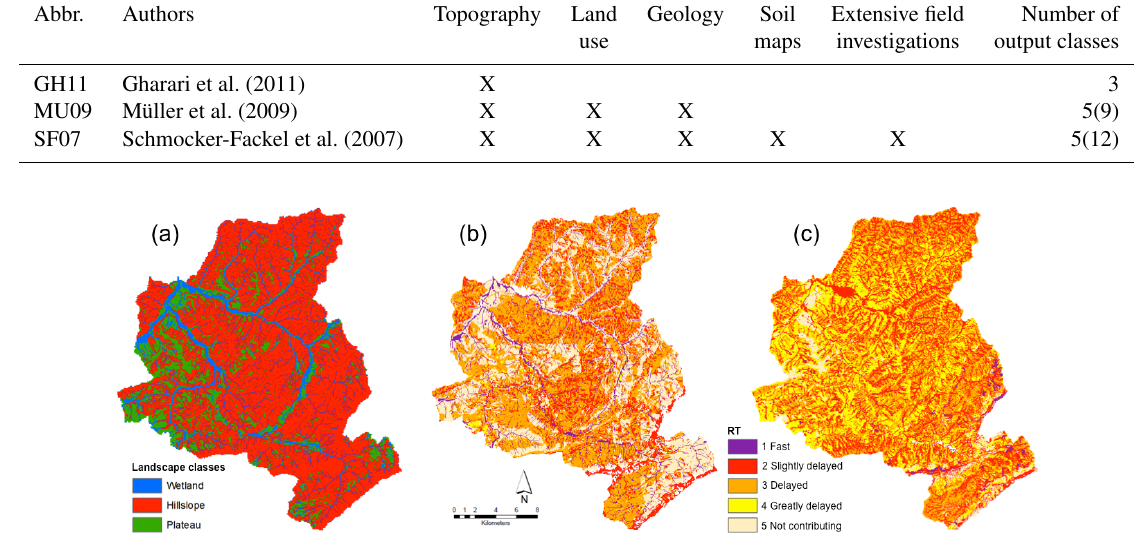
Figure 3. Process maps for the Emme catchment map according to (a) Gharari et al. (2011), (b) Müller et al. (2009), and (c) Schmocker- Fackel et al. (2007). RT = runoff type.